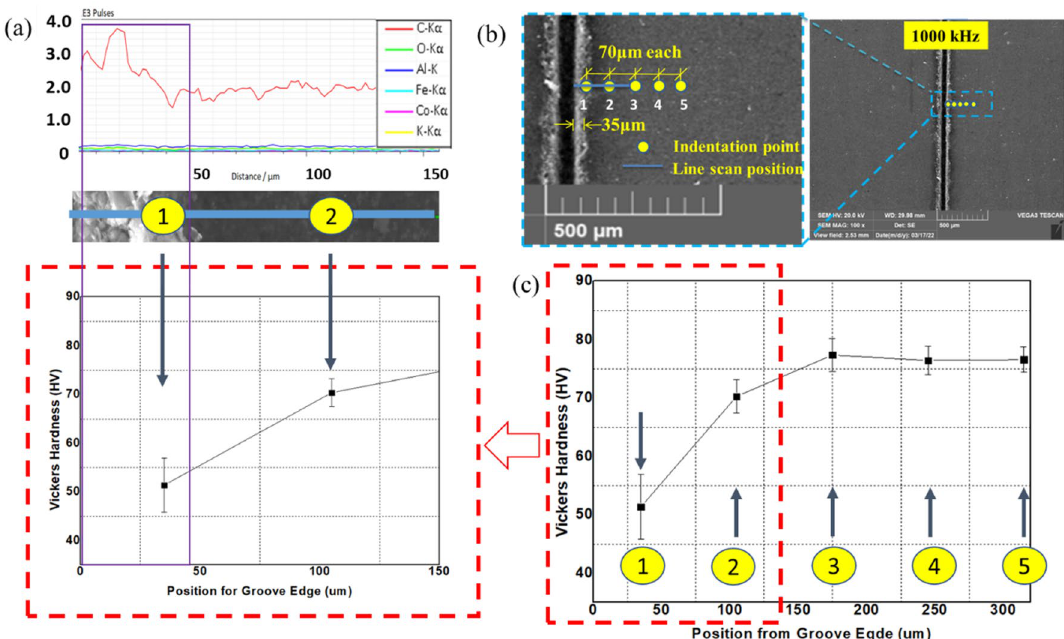
Figure 22. Chemical and hardness tests on surface—1000 kHz; ( a ) EDX line scan ( b ) measurement configuration ( c ) Vickers hardness.